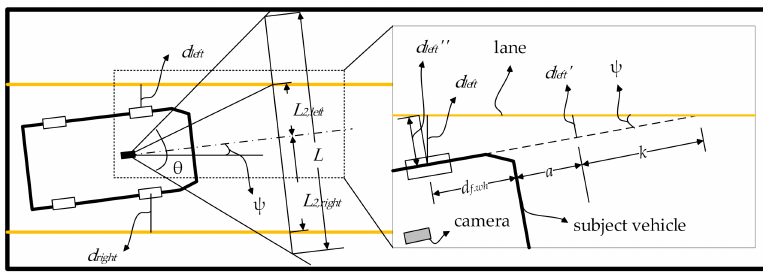
Figure 2. Geometry of vehicle, camera, and lead vehicle.